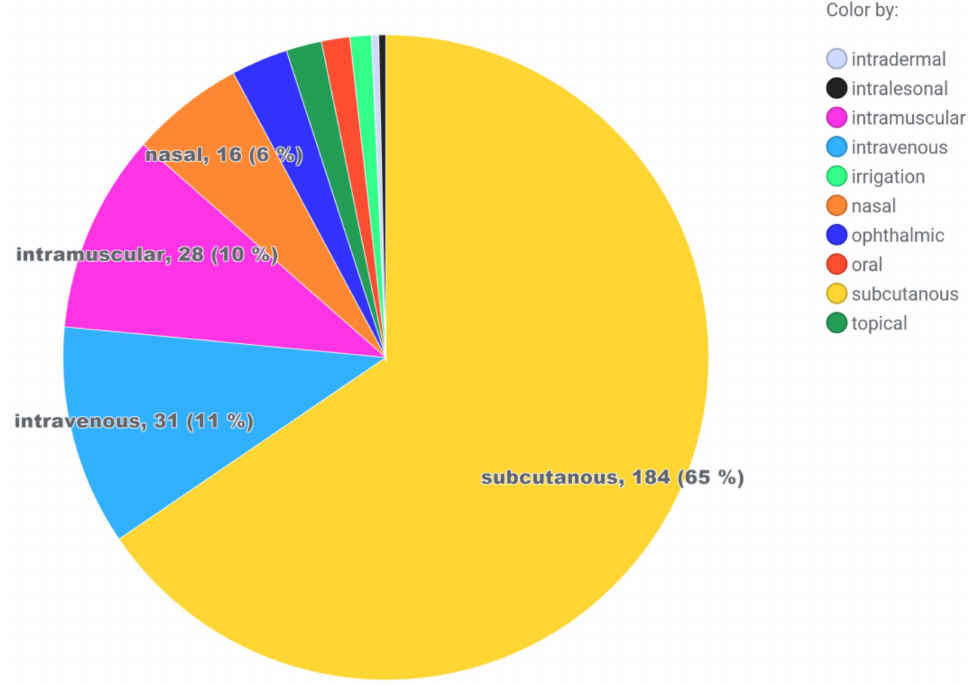
Figure 1. Number and percentage distribution of preservative-containing market products (protein and peptides) in relation to the application route. This figure includes products containing one preservative as well a preservative combinations and products with antibacterial